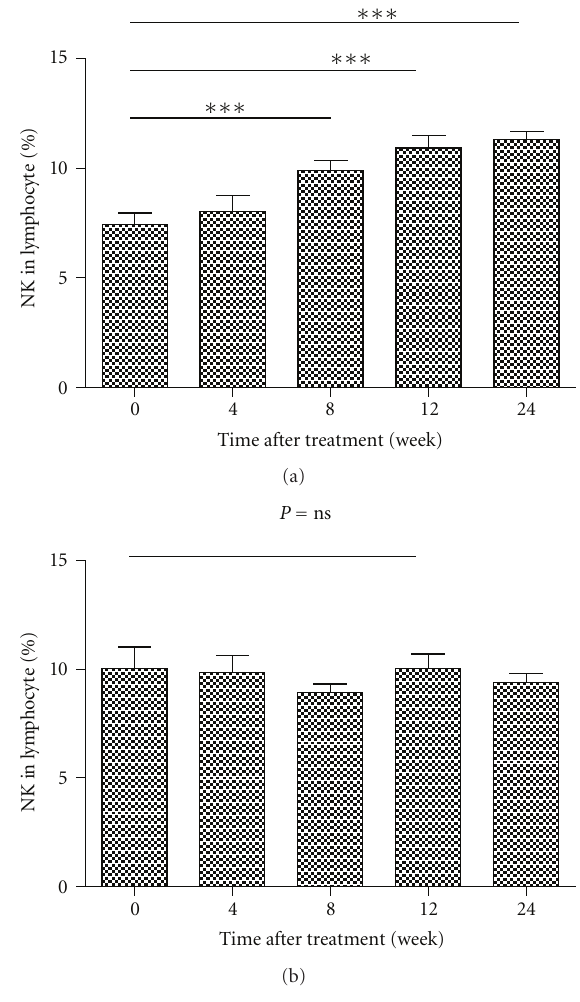
Figure 5: Antiviral treatment TDF but not ADV results in increase of NK cells. Data are presented as mean ± SEM (a). ∗∗ P < 0 . 01, ∗∗∗ P < 0 . 001 Data are expressed as mean ± SD of the percentages of NK in 12 patients treated with tenofovir (a) or adefovir (b) at the indicated time points after treatment. (a, b): the percentages of NK cells in